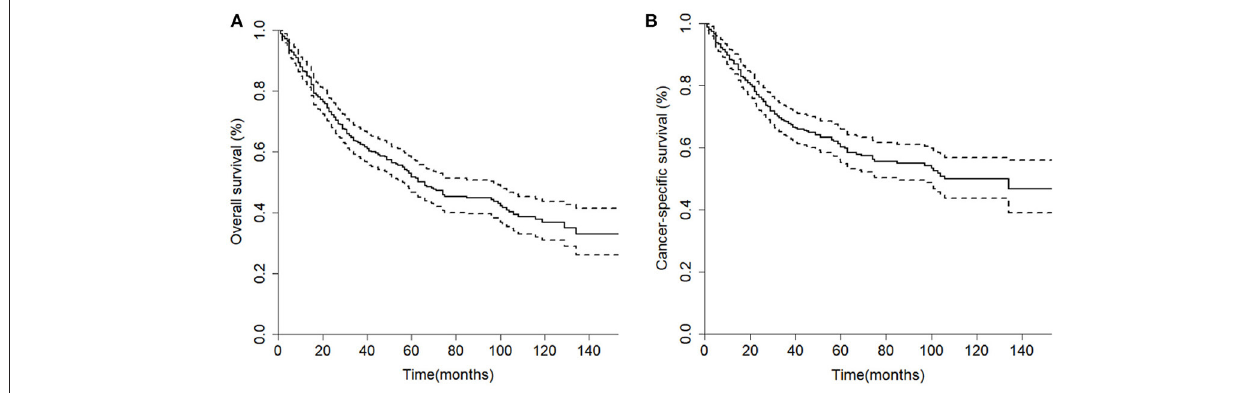
FIGURE 2 | Kaplan-Meier curves of the 446 patients in the cohort. (A) Overall survival; (B) Cancer-specific survival.